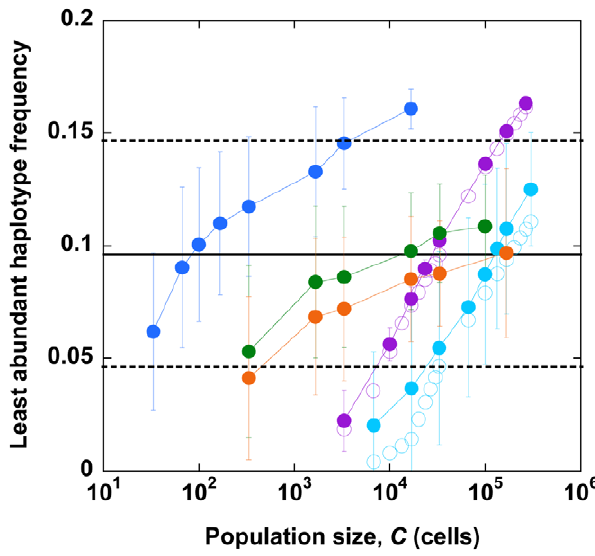
Figure 9. Estimation of N e using the linkage disequilibrium test. The frequency of the least abundant haplotype in a two-locus/two- allele model determined from our simulations (solid symbols) and by Rouzine and Coffin [15] (open symbols) as functions of the population size, C , assuming neutral evolution (purple), evolution with selection (cyan), and evolution with selection and recombination where the number of infections per cell is constant at 3 (blue), or follows a distribution determined from a viral dynamics model (see text) with k i = k 0 (green) or k i =0.7 k i -1 (orange). Error bars represent standard deviations. Values of C at which predictions from simulations match experimental estimates [15] of the least abundant haplotype frequency (black line) yield N e . 95% confidence limits on the experimental data are also shown (dotted line).